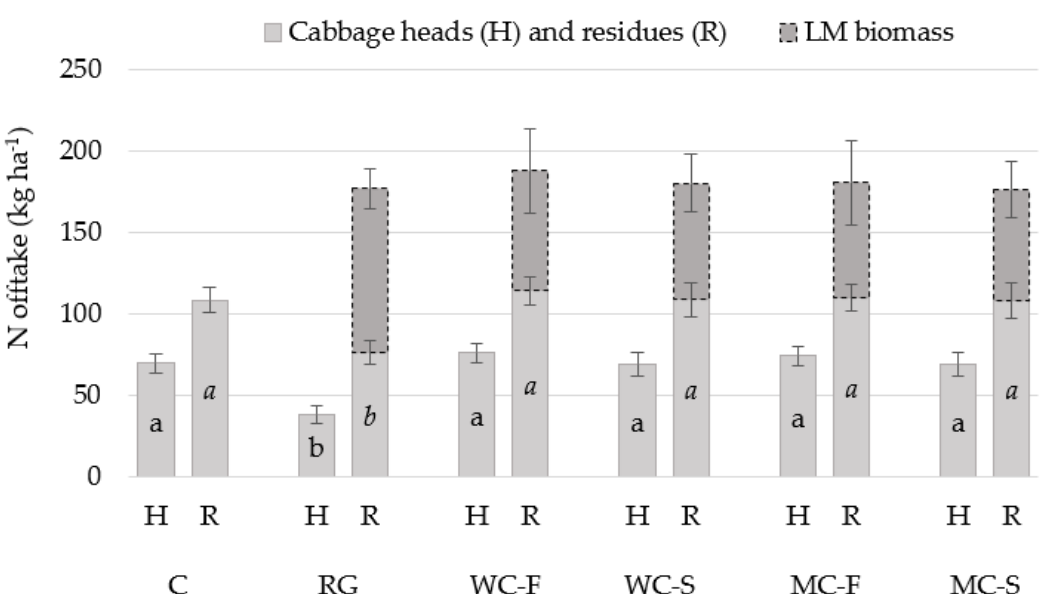
Figure 6. Influence of living mulches on N offtake by harvested cabbage heads (H) and residues remaining on the field (R) with LM biomass (only in case of STU and STT) after harvest at both locations. Values with at least one identical letter (italics for residues) indicate non-significant differences among LM treatments at α = 0.05. Values without letters were not found to be significantly different indicated via global F test. C = control, RG = perennial ryegrass, WC-F = white clover—fall seeded, WC-S = white clover—spring seeded, MC-F = micro clover—fall seeded, MC-S = micro clover—spring seeded.